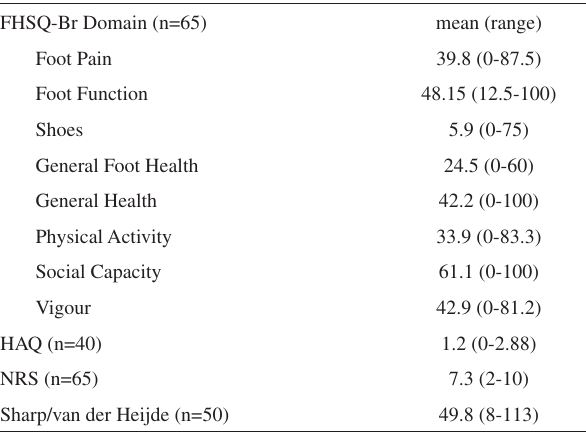
Table 3 - FHSQ-Br mean scores across the domains, HAQ,